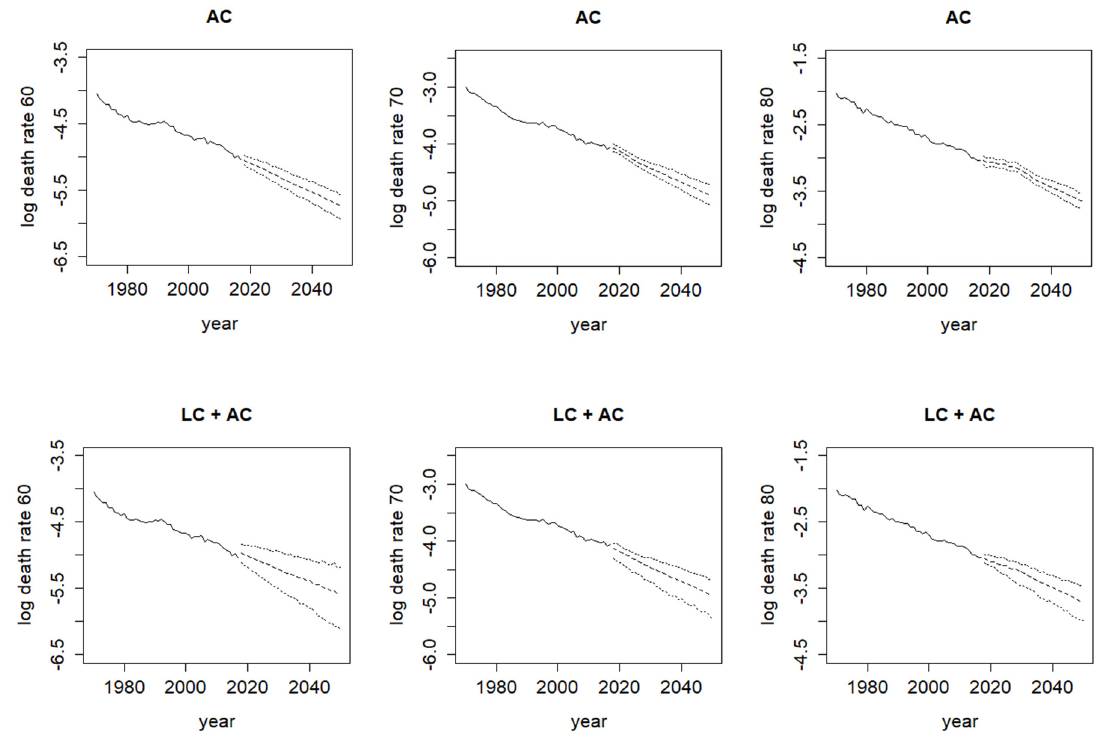
Figure 7. Log death rates at ages 60, 70, and 80 from 1970 to 2050 (solid—observed values; dashed—projected values; dotted—95% prediction intervals) under Bayesian age-cohort model (alone) and mixture model.